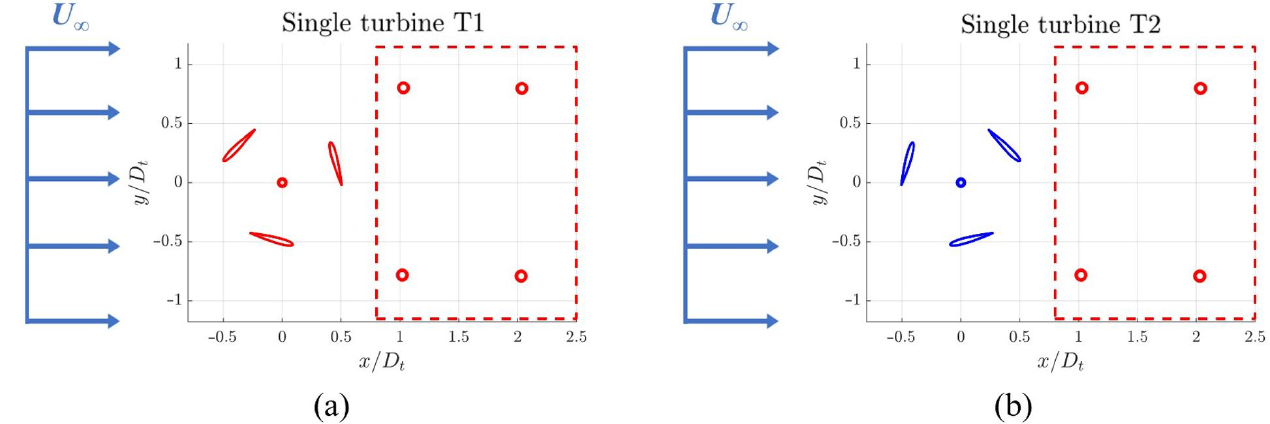
Figure 5. An illustration of the turbine configurations studied in this article: Turbine T1 ( a ) and Turbine T2 ( b ). The regions of interest are enclosed inside the red dashed lines, and the arbitrary points for time-series data extraction are highlighted with the 4 red circles inside the dashed lines.